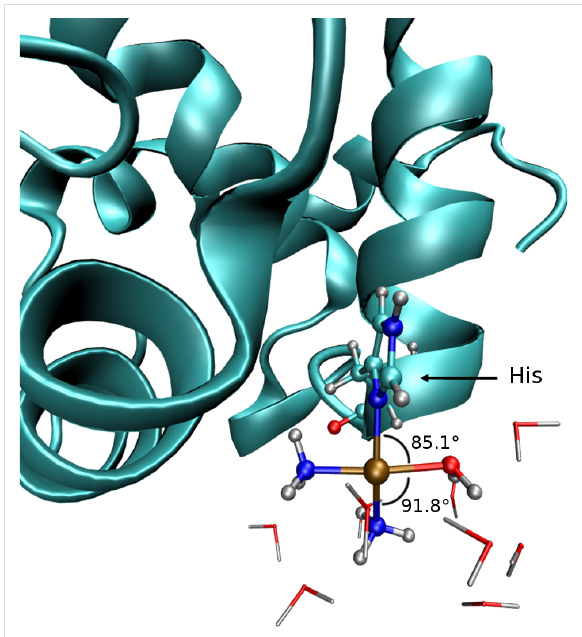
Figure 13: Structure of the QM/MM optimized cisplatin–protein adduct [94].